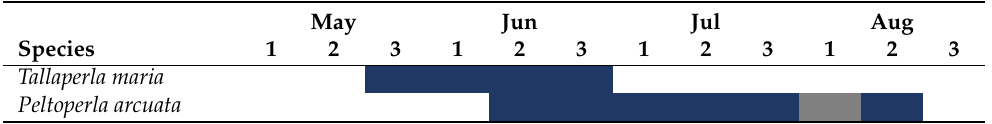
Figure 11. Elevation boxplots for Peltoperlidae species recorded from Maryland. Boxes represent the interquartile range, while vertical lines extend to the minimum and maximum values. The horizontal line within the interquartile range represents the median elevation. Outliers are shown with large, solid circles. Small, individual points overlaid on each boxplot illustrate the distribution of observations. Table 8. Recorded adult Peltoperlidae presence in Maryland. Months are broken into three 10-day periods. Dark blue squares represent periods with collections. Gray squares represent periods when species may be